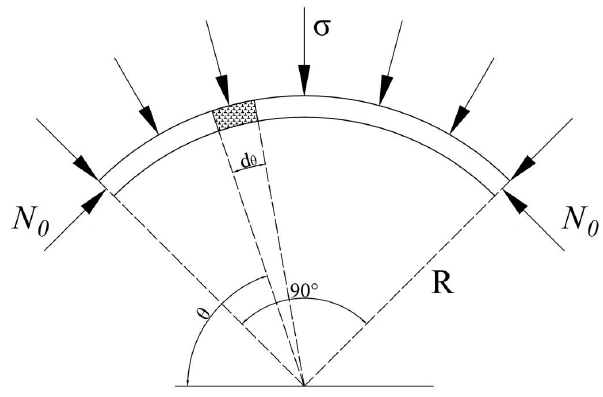
Figure 14. Mechanical model of a concrete-filled steel tube (CFST) arched support force schematic.